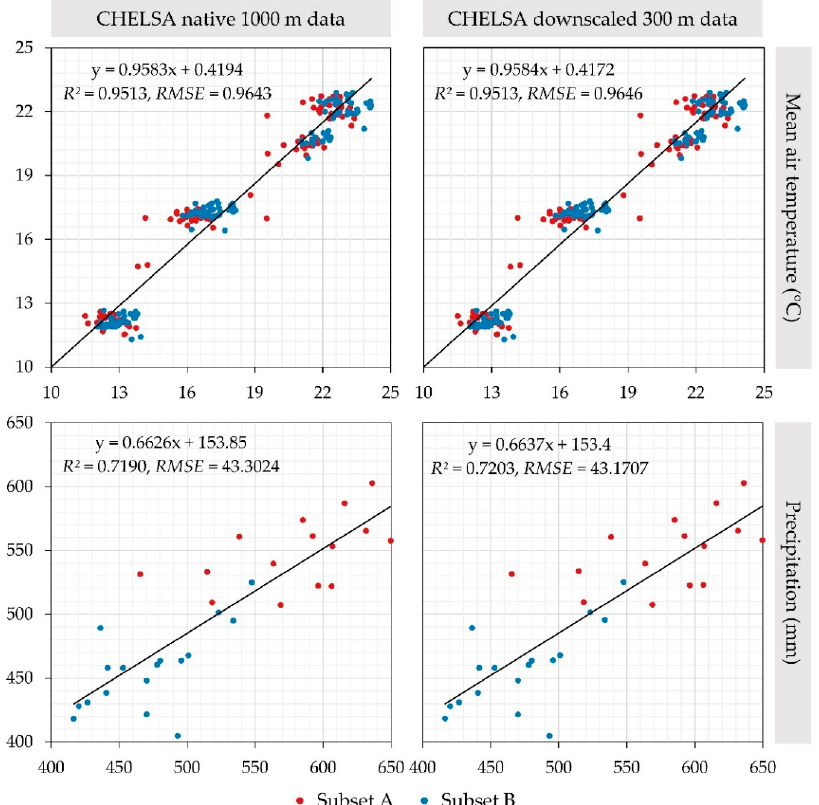
Figure 5. Scatterplot between ground truth climate data from DHMZ and the most accurate downscaling B-spline interpolation method.